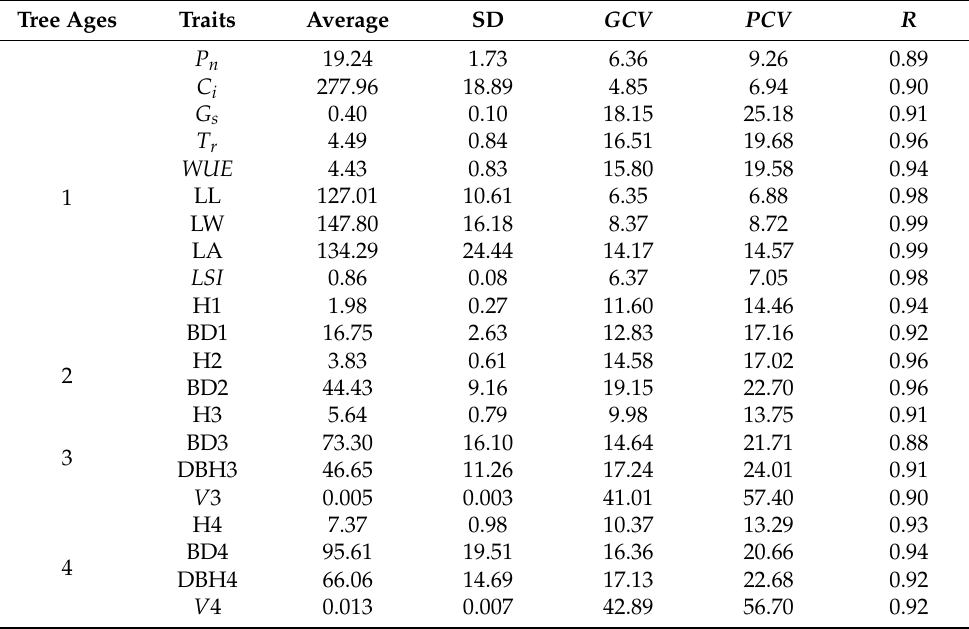
Table 3. Genetic and variation parameters of different traits.